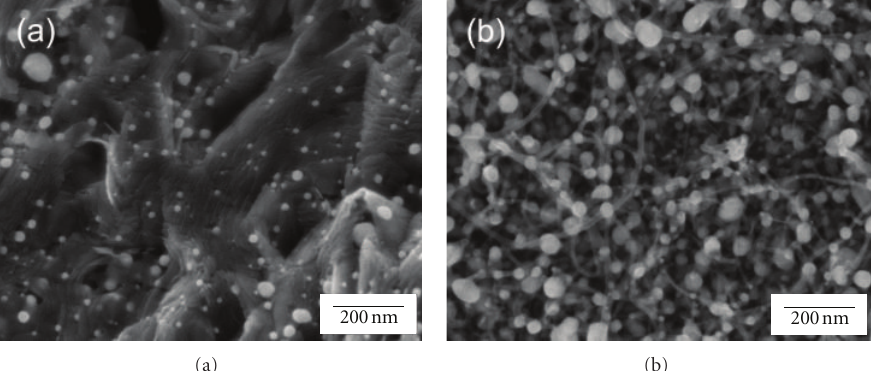
Figure 1: SEM micrographs of Pd-NPs supported on (a) carbon foam support (Pd/Foam) and (b) CNT-grafted foam support (Pd/CNT/